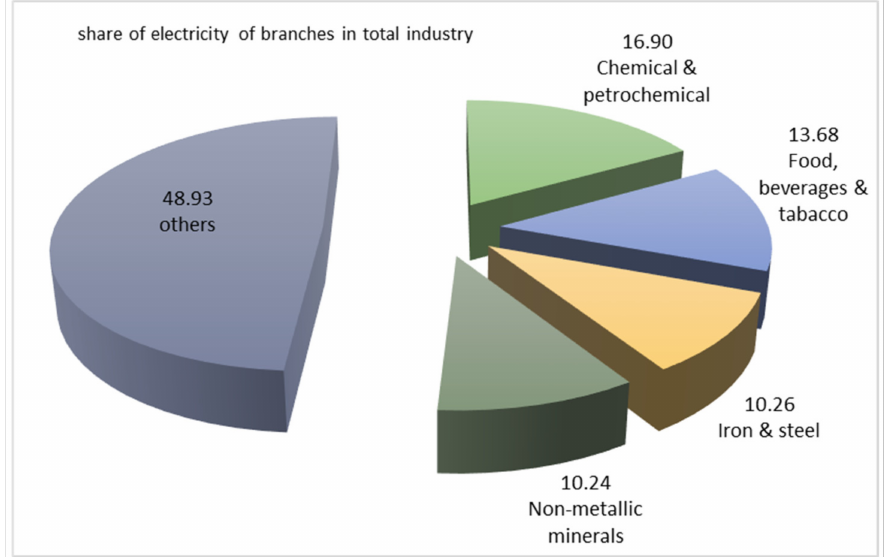
Figure 3. Shares of electricity in Polish industry by branches in total industry. Source: own elaboration based on: Gospodarka paliwowo-energetyczna w latach 2011–2020. Statistics Poland (GUS)